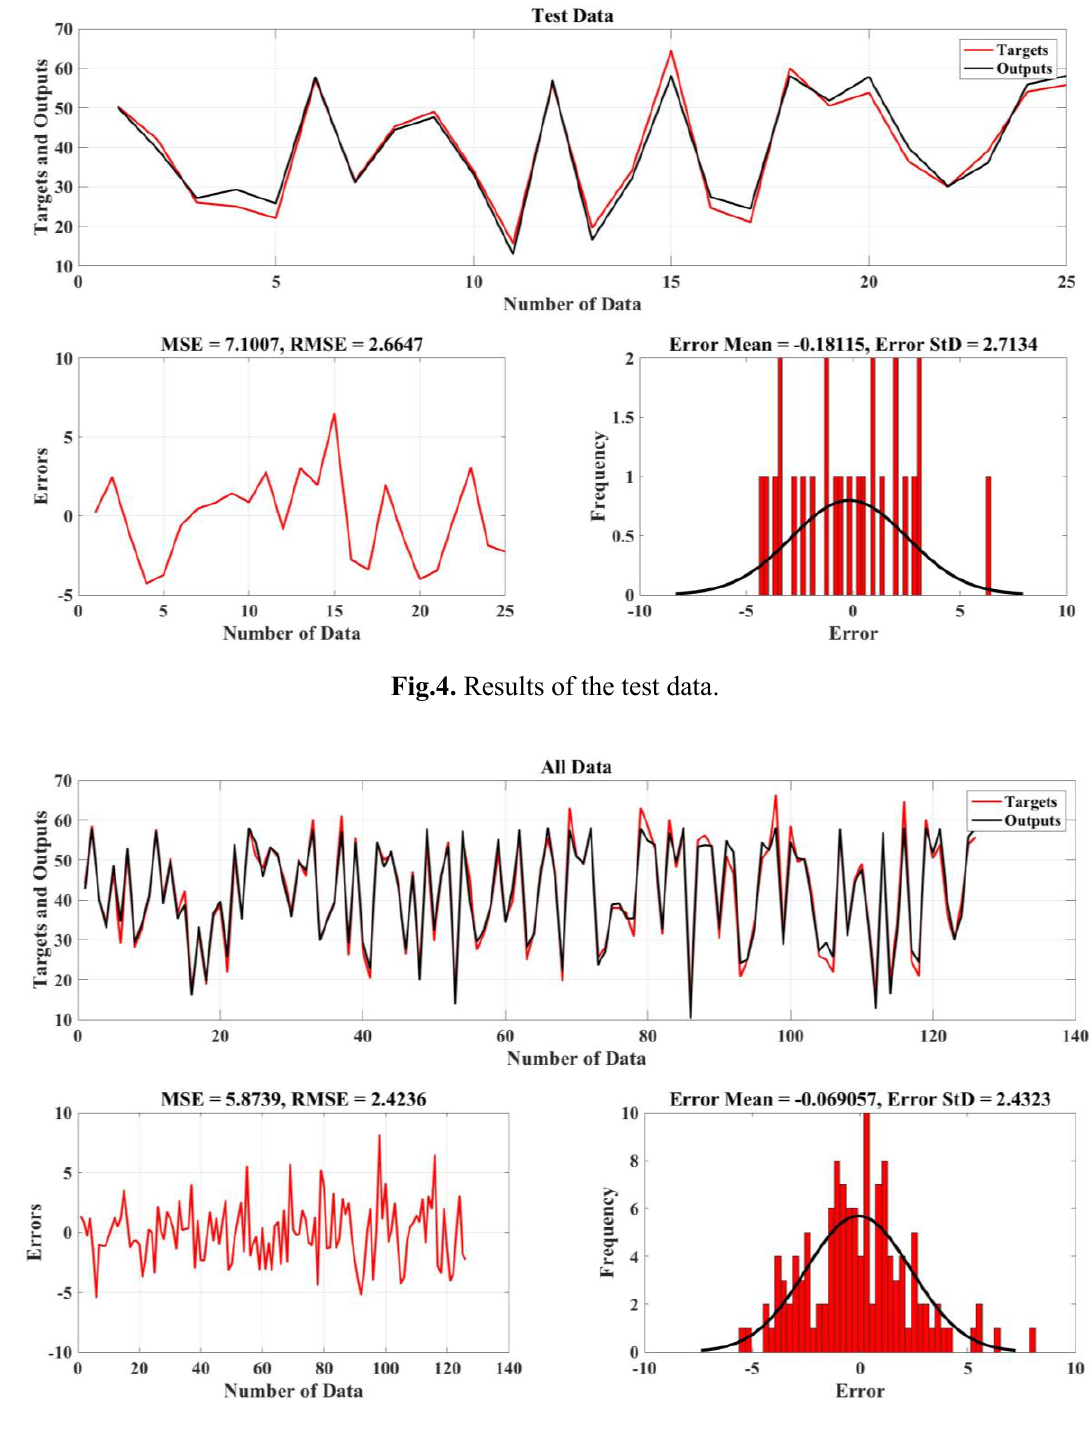
Fig.5. Results of all